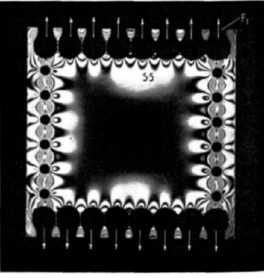
Figure 8. Photoelastic fringe pattern image of a biaxially loaded flat square specimen with edge holes and loaded by vertical forces with disturbance from compression zones on show [74].